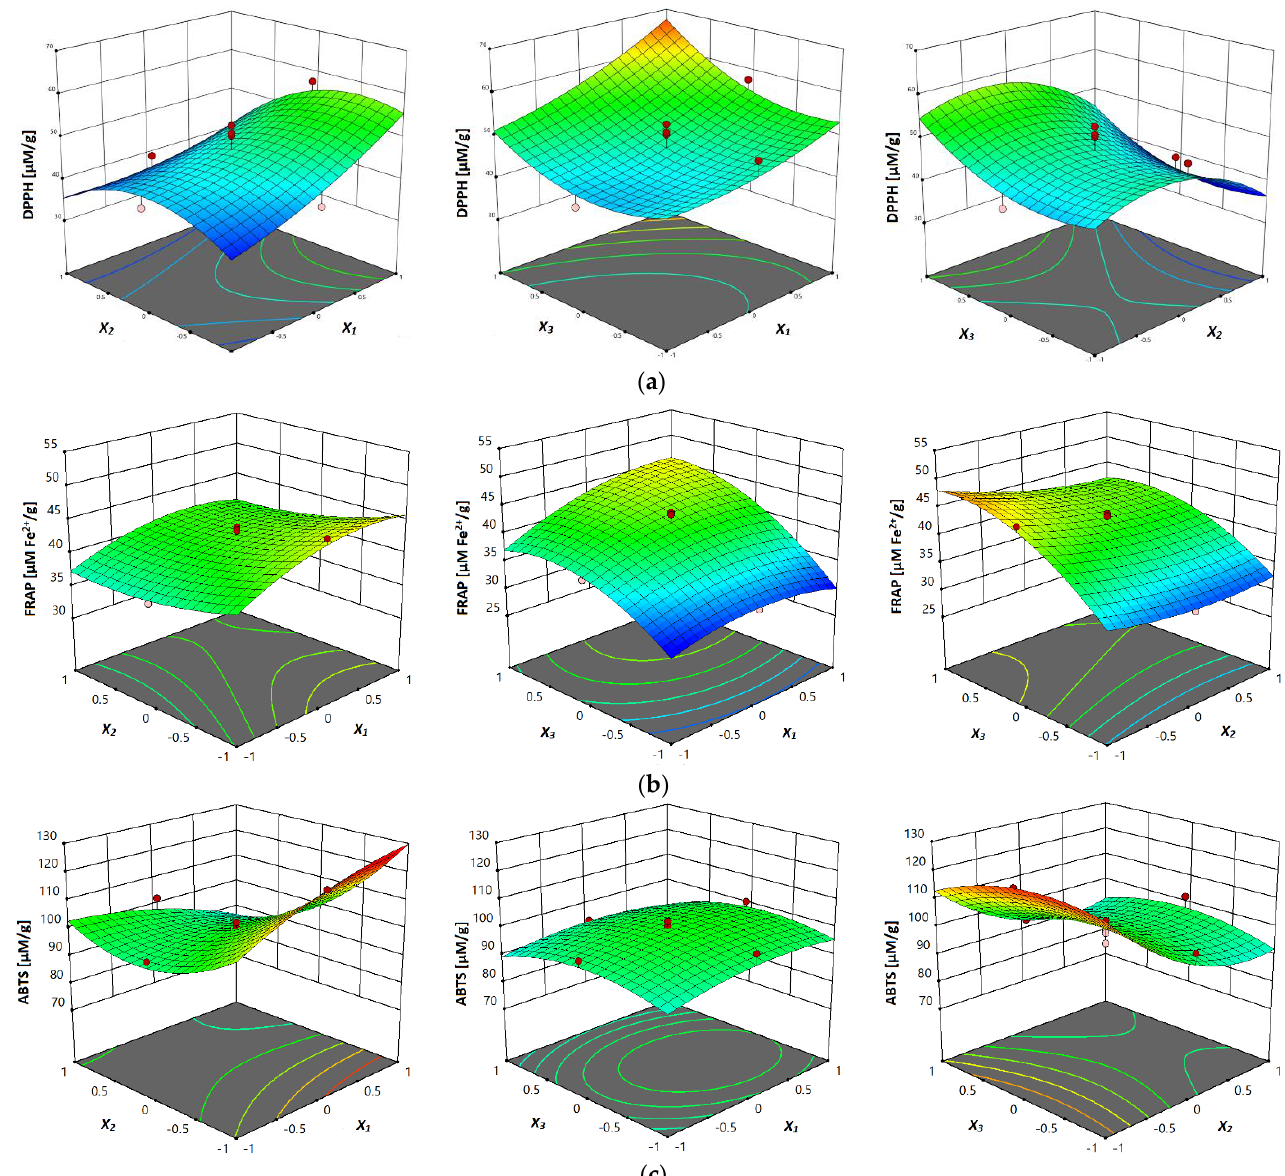
Figure 3. Response surface plots showing combined effects of UAE parameters ( x 1 temperature; x 2 ethanol concentration; x 3 liquid – solid ratio) on: ( a ) DPPH antiradical activity, ( b ) FRAP reducing capacity and ( c ) ABTS antiradical activity.